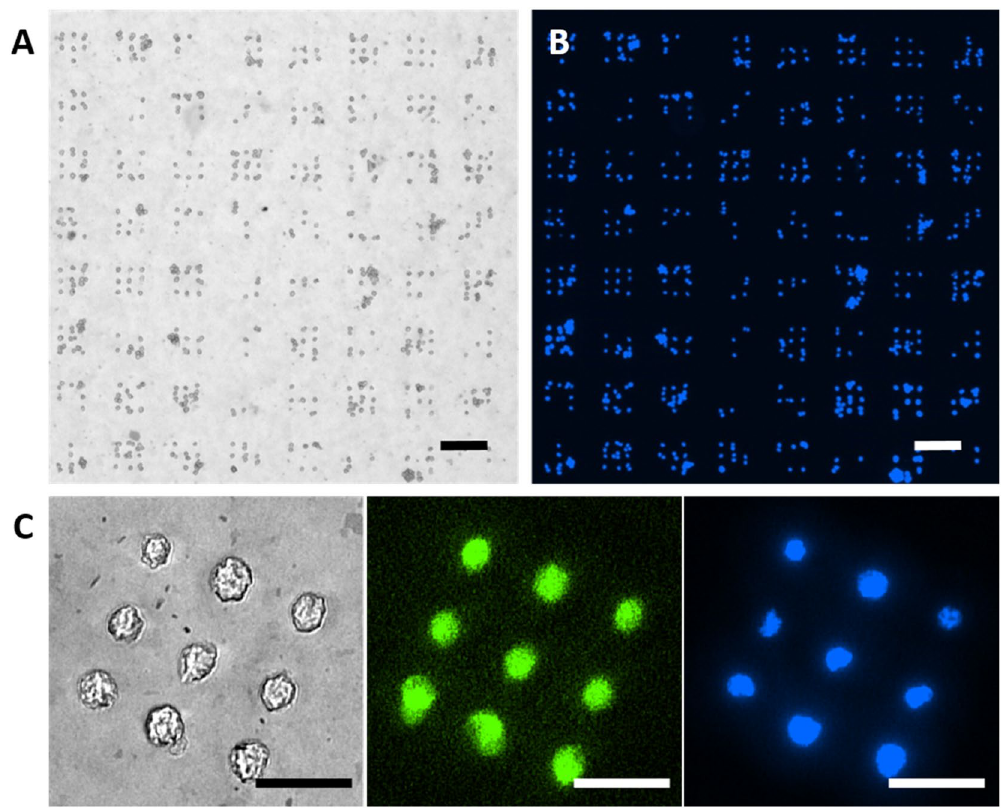
Figure 4. Comparison of cell adhesion on GO coating and control. ( A ) Bright field image of 3T3 cells on a protein microarray spotted on a GO coating. Scale bar equals 100 µm. ( B ) Corresponding fluorescence image of stained cell nuclei. Scale bar equals 100 µm. ( C ) Close-up of a single pattern subunit in bright field, and single fluorescence channels for fibronectin (green) and cell nuclei (blue) signal. Scale bars equal 50 µm.